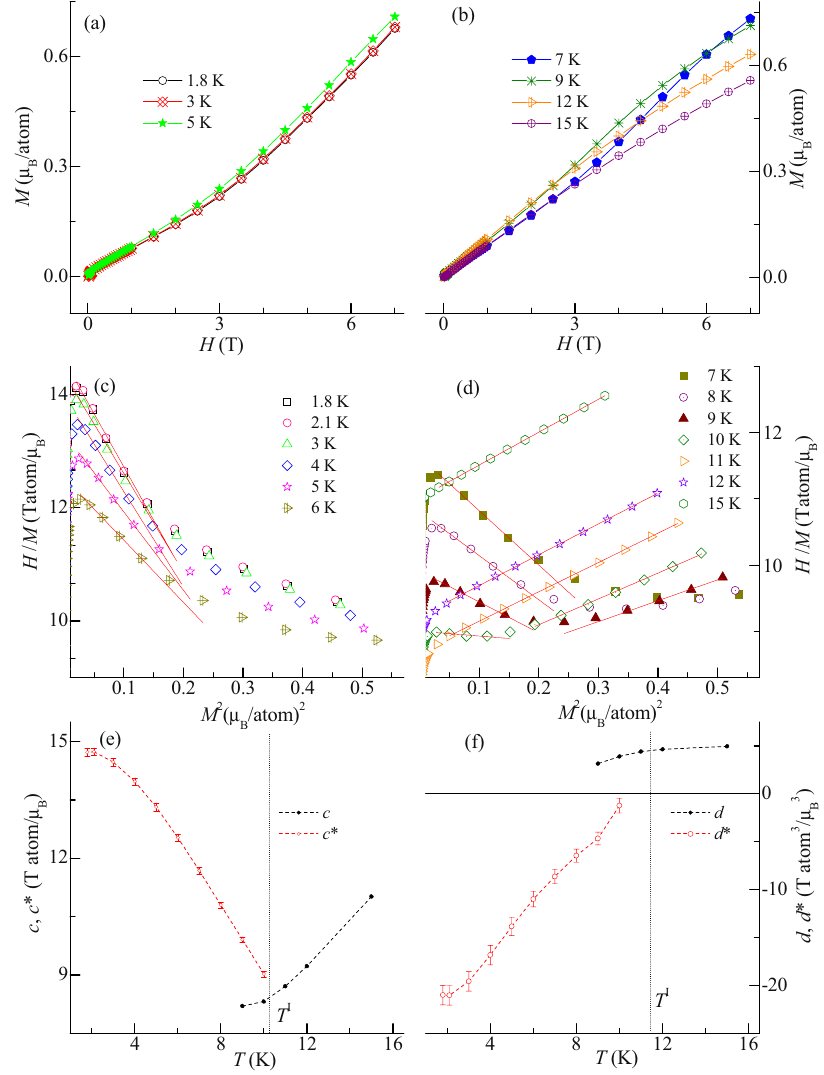
Figure 6. ( a , b ) Virgin isothermal magnetization ( M ) curves as a function of magnetic field (0 to 7 T) at different temperatures. ( c , d ) H / M versus M 2 in temperature range of 1.8–15 K. Red curve shows the linear fitting of the plots. ( e , f ) Intercepts ( c , c * ) and slopes ( d , d * ) plotted as a function of